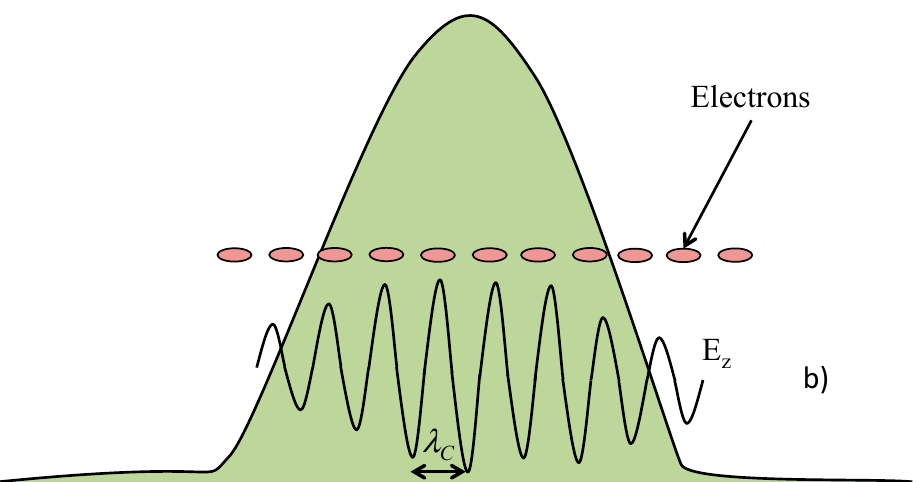
Figure 4. Electron bunch and radiation pulse interaction: ( a ) phase locking; and ( b ) electrons and radiation electric field interaction.